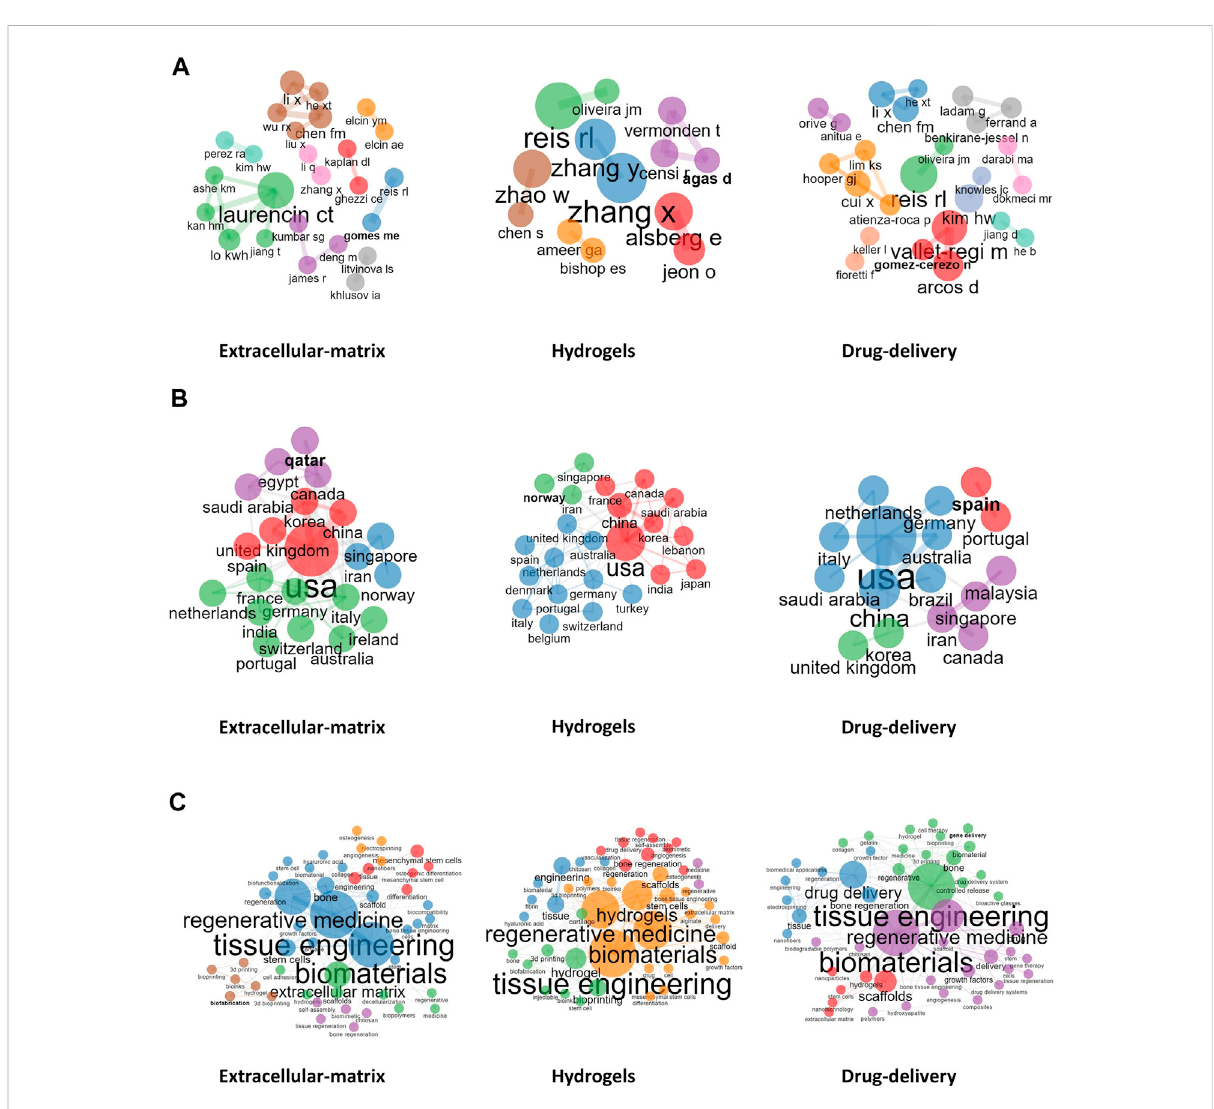
FIGURE 4 Visualized analysis. (A) : Collaboration between authors; (B) : Collaboration between countries; (C) : Collaboration between Author